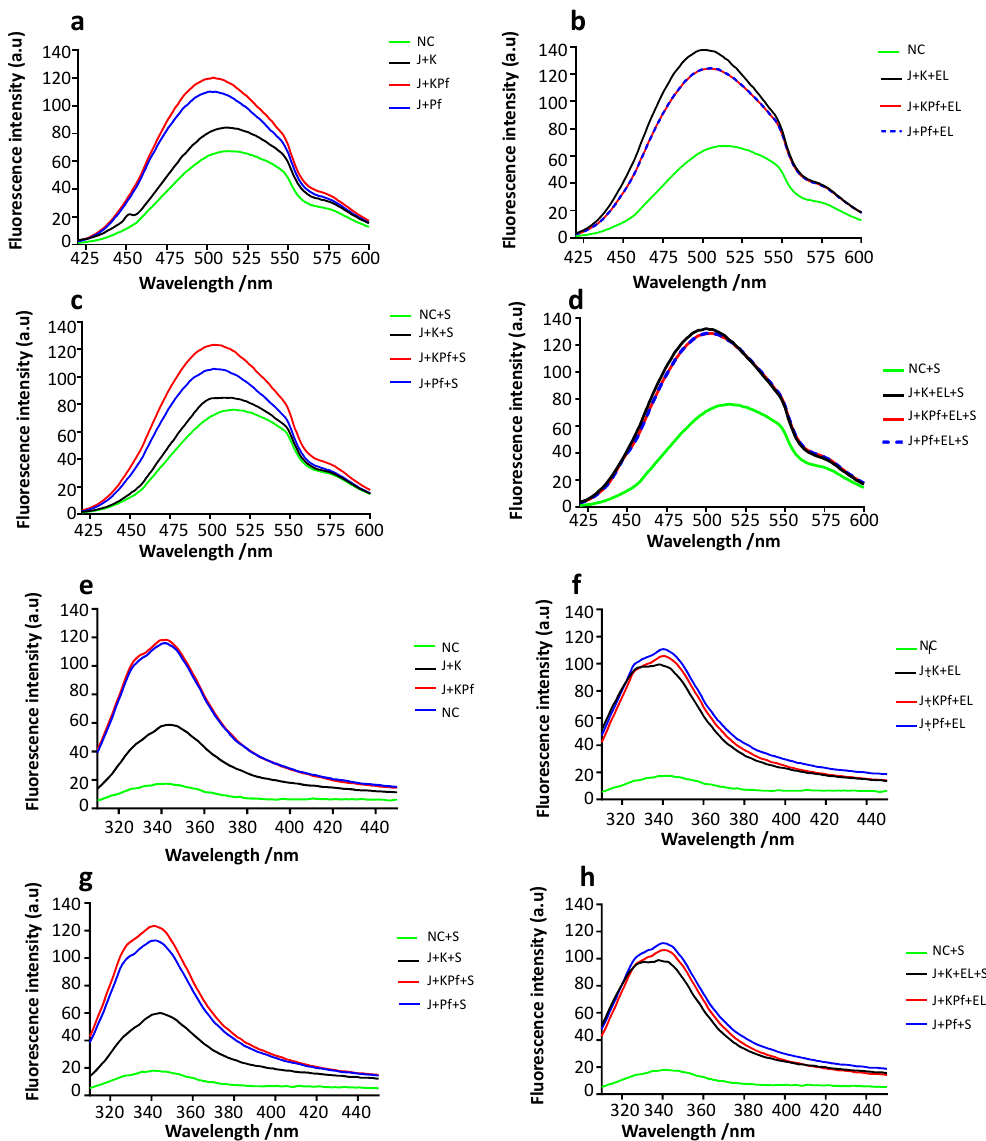
Figure 4. Co-production of PfAdoMetDC with PfHsp70-1 and KPf facilitates the folding process. PfAdoMetDC co-expressed with the various chaperone sets was subjected to either ANS extrinsic fluorescence analysis ( a – d ) or intrinsic fluorescence analysis ( e – g ). PfAdoMetDC produced in the absence of supplementary chaperones (NC) or presence of various heterologous chaperones combinations: DnaK + DnaJ (J + K); DnaK + DnaJ + GroEL (J + K + EL); PfHsp70 + DnaJ (J + Pf); PfHsp70 + DnaJ + GroEL (J + Pf + EL); KPf + DnaJ (J + KPf); KPf + DnaJ + GroEL (J + KPf + EL). The fluorescence analysis was conducted in the absence or presence of the SAM